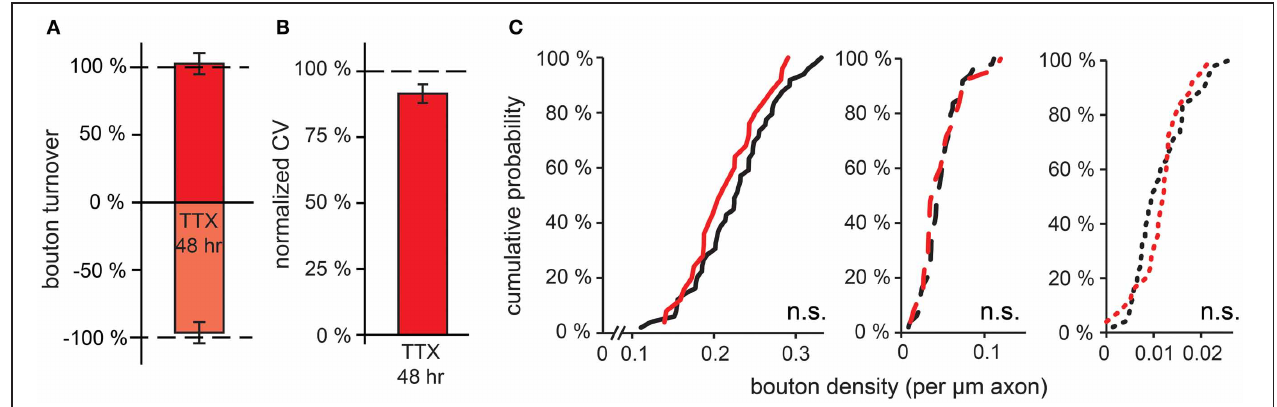
FIGURE 5 | Effect of prolonged (48h) reduction in network activity on GABAergic bouton dynamics. (A) Normalized bouton turnover after 48h TTX treatment. Control values: bouton gain = 8 . 1 ± 0 . 2%, bouton loss = 8 . 7 ± 0 . 3%. (B) Normalized coefficient of variation (CV) of bouton volume